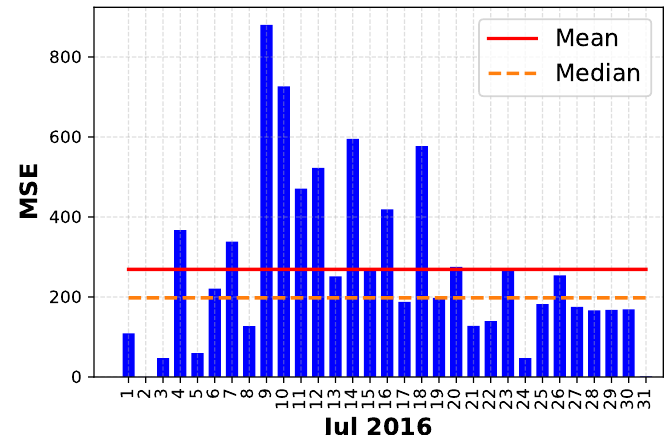
Figure 17. MSE performance of the three-layer ANN model for the month of July